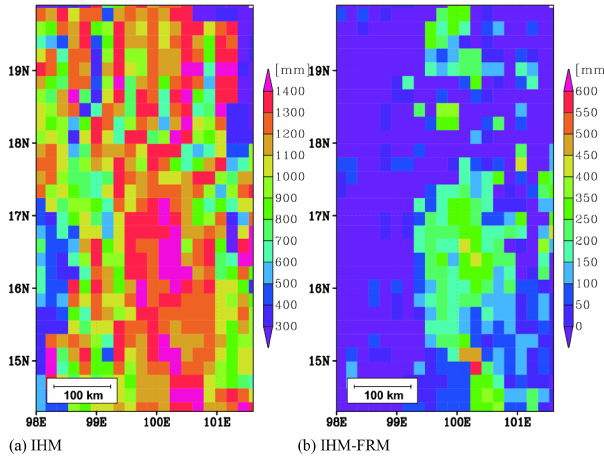
Figure 6. Averaged annual evapotranspiration by the IHM simula- tions and how it differs from the FRM (IHM-FRM).